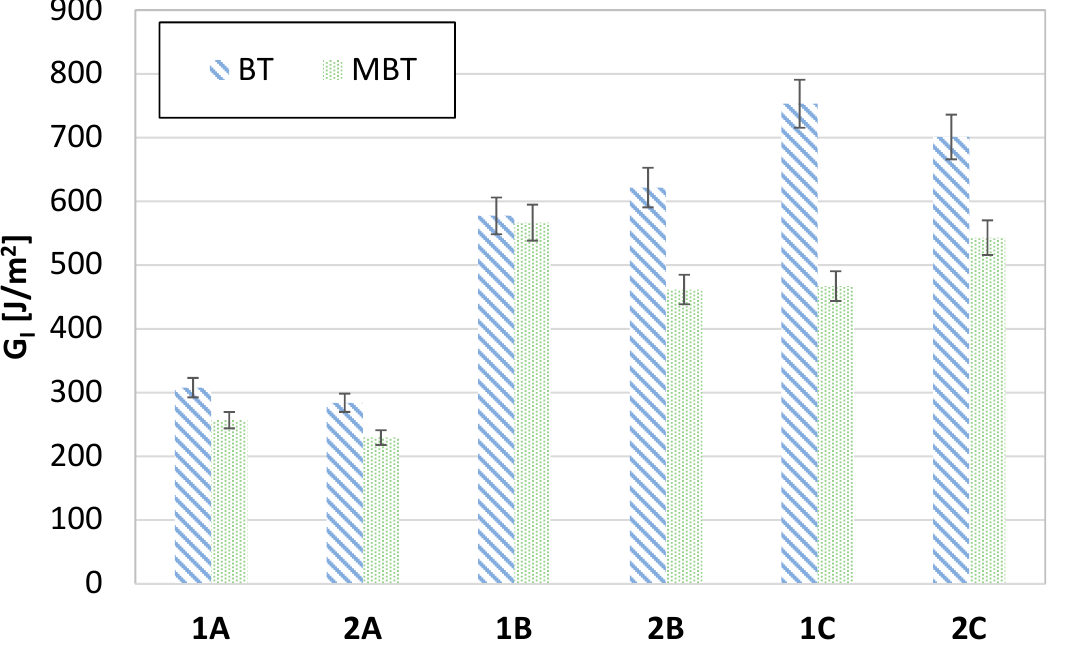
Figure 5. G I values calculated by Beam Theory (BT) and Modified Beam Theory (MBT).